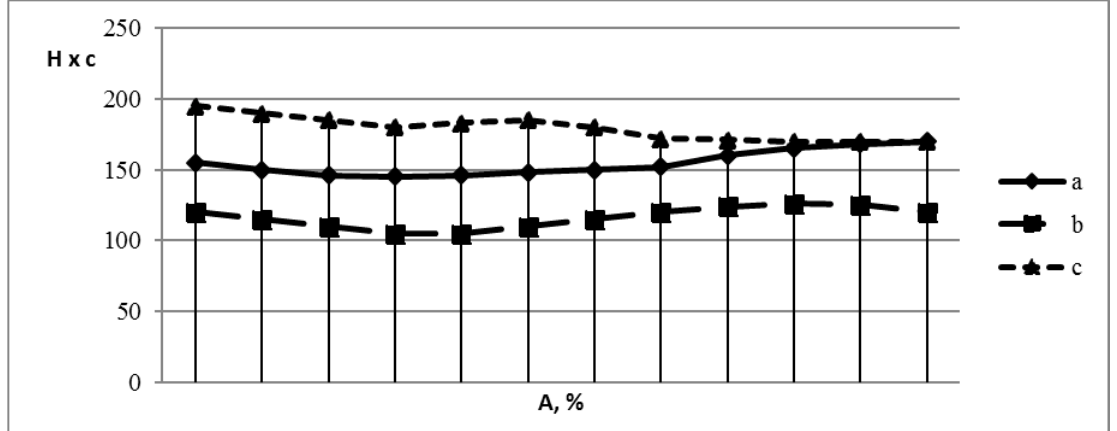
Fig. 2. Change of resulting force impulse ( Н•с ) for elite cyclists’ pedaling cycle in trainings of speed power ( a ), an- aerobic ( b ) and aerobic ( c ) orientation. A – Period of